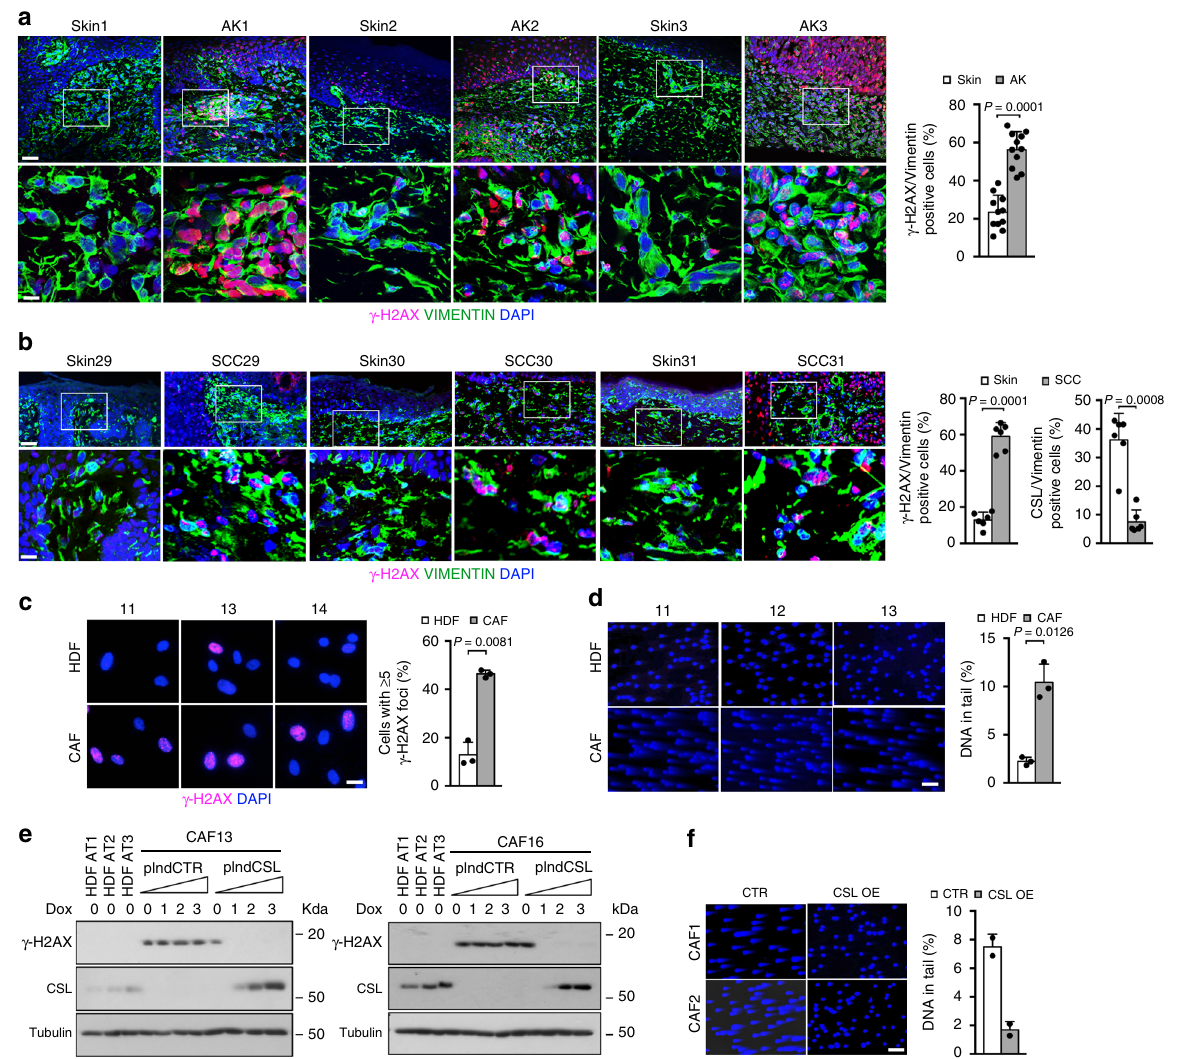
Fig. 2 DNA damage induction in CAFs can be counteracted by CSL overexpression. a γ -H2AX (magenta) and VIMENTIN (green) immunostaining of AK underlying stroma versus fl anking unaffected skin from multiple patients. Shown are representative low and high magni fi cation images (scale bars, 50 and 10 μ m) and quanti fi cation of double positive γ -H2AX and VIMENTIN cells. Decreased CSL expression and limited leukocytes in fi ltration were previously shown for fi ve lesions 2 and for the remaining they were assessed by double immunostaining with anti-VIMENTIN and anti-CSL/anti-CD45 antibodies (Supplementary Fig. 1a). >120 VIMENTIN positive cells were counted per sample. n (AK/Skin) = 11, **** p = 0.0001, two-tailed paired t -test. b γ -H2AX (magenta) and VIMENTIN (green) immunostaining of SCC underlying stroma versus fl anking unaffected skin from multiple patients. Shown are representative low and high magni fi cation images (scale bars, 50 and 10 μ m) and quanti fi cation of double positive γ -H2AX and VIMENTIN cells. Decreased CSL expression and limited leukocytes in fi ltration were assessed by double immunostaining with anti-VIMENTIN and anti-CSL/anti-CD45 antibodies (right panel and Supplementary Fig. 1b). >77 VIMENTIN positive cells were counted per sample. n( SCC) = 6, n( Skin) = 6, *** p < 0.001, two-tailed paired t -test. c γ -H2AX immunostaining of CAFs derived from three skin SCCs and matched HDFs from unaffected skin of the same patients. Scale bar, 10 μ m. >175 cells were counted per sample. n (CAF strain) = 3, n (matched HDF strain) = 3, ** p < 0.01, two-tailed paired t -test. d Comet assays of three CAF and matched HDF strains. Scale bar, 50 μ m. >135 cells were analyzed per sample. n (CAF strain) = 3, n (matched HDF strain) = 3, * p < 0.05, two-tailed paired t -test. e Immunoblot of γ -H2AX and CSL protein levels (with γ -TUBULIN normalization) in two CAF strains infected with an inducible CSL overexpressing lentivirus versus empty vector control and treated with increasing concentrations of doxycycline for 5 days. 0, 1, 2, and 3 represent 0, 50, 200, and 500 ng ml − 1 of doxycycline, respectively. Three untreated HDF strains were analyzed in parallel as a reference. n (CAF strain) = 2. f Comet assays of two CAF strains infected with a constitutive CSL overexpressing retrovirus versus empty vector control for 5 days. Scale bar, 50 μ m. > 303 cells were analyzed per sample. n (CAF strain) = 2. Bars represent mean ±